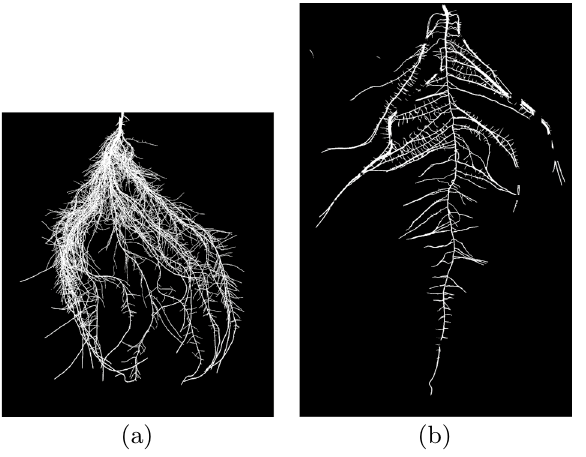
Figure 14. Output segmentation masks from the hold out cucumber set showing ( a ) a segmentation with Dice score 0.9189 and ( b ) a segmentation with Dice score 0.909. Note that in image a) there are many fine details of the root structure which are retained in the segmentation. In image ( b ) we can see that roots which have grown together and appear to be a single larger root contain gaps in their